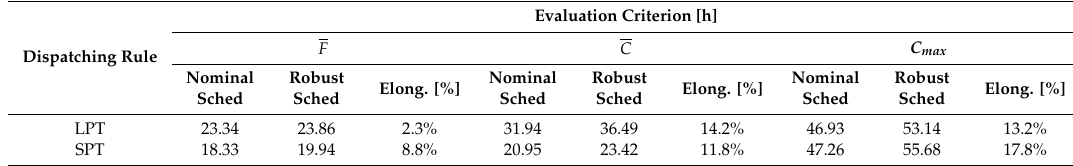
Table 7. Evaluation criteria in the nominal and robust